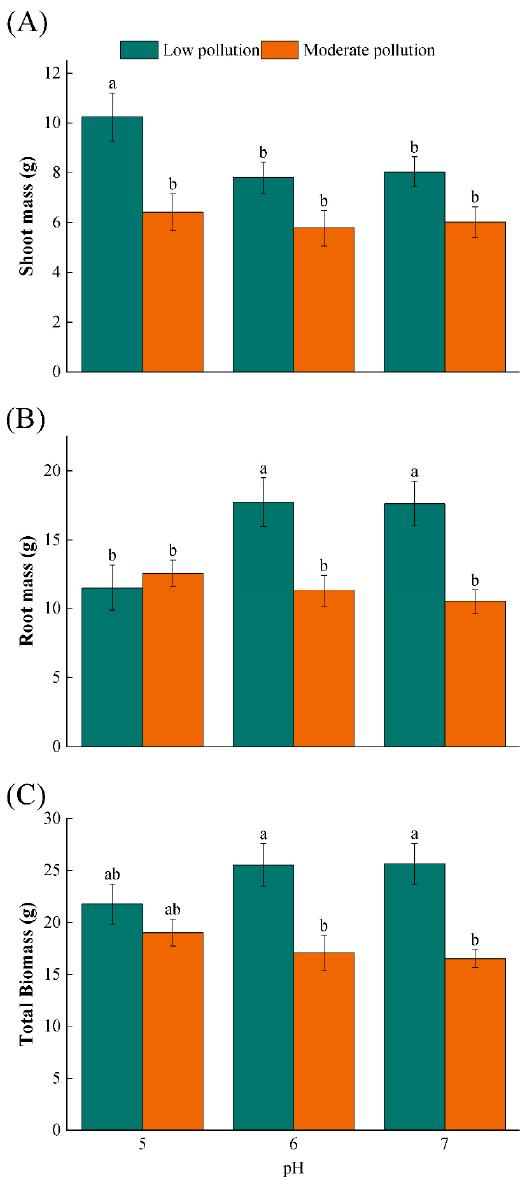
Figure 1. The shoot mass ( A ), root mass ( B ), and total biomass ( C ) of Polygonum hydropiper growing under three soil pH values at two cadmium (Cd) contamination levels. Different lowercase letters (a, b, c) indicate significant differences among the three pH treatments.